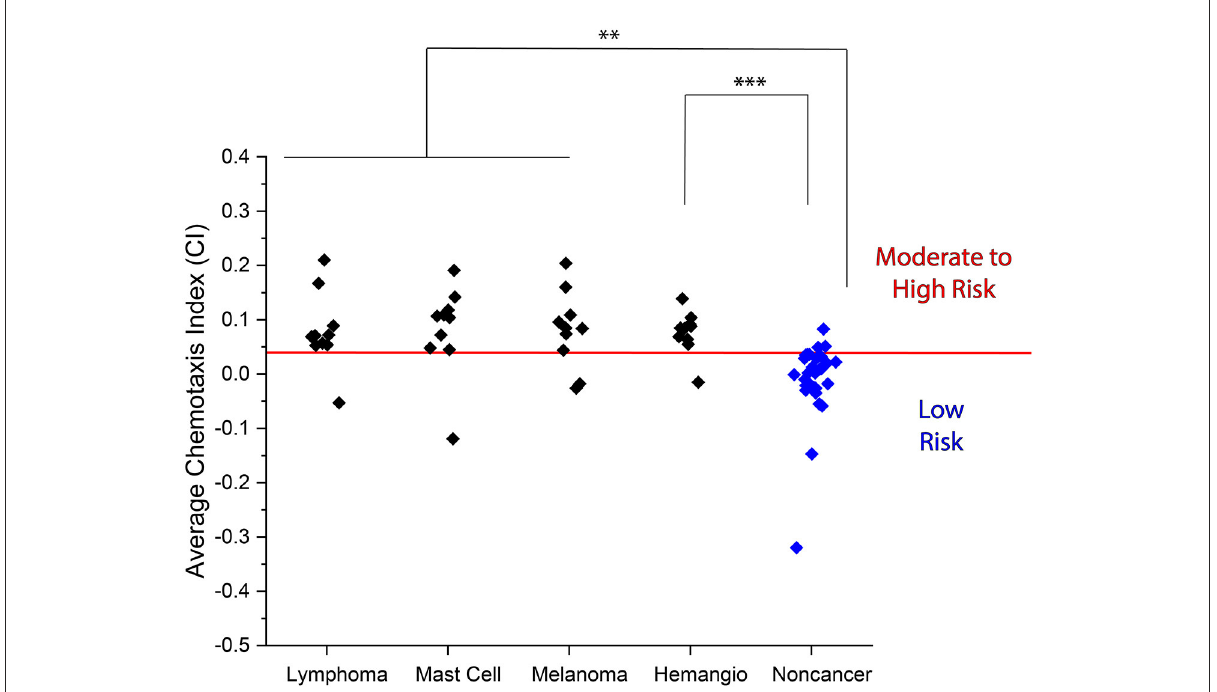
FIGURE3 Average CI for urine samples obtained from lymphoma, mast cell tumor, melanoma, and hemangiosarcoma patients as compared to non-cancer samples. (Lymphoma: 0.079